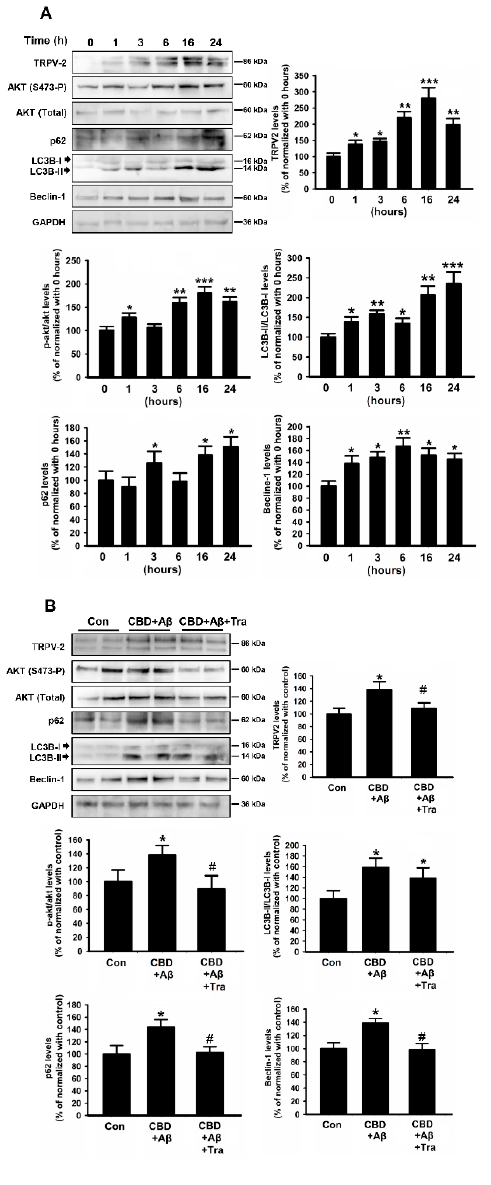
Figure 7. CBD induced autophagy in microglial cells via TRPV2 by promoting the upregulation of Akt. ( A ) BV2 microglia cells incubated with A β 42 were analyzed using Western blot in the presence of CBD (5 µ M) for the indicated time. ( B ) BV2 microglial cells were pretreated with Tra (tranilast 75 µ M) for 1 h and then treated with CBD for 24 h. Band densitometry quantification of TRPV2. The autophagy flux expression was normalized to GAPDH. The phosphorylation of Akt was normalized to the total Akt level ( n = 4 per group). * p < 0.05, ** p < 0.01, and *** p < 0.001 are compared with the control by Tukey’s test. # p < 0.05 mean CBD + A β with or without siRNA by Student’s t